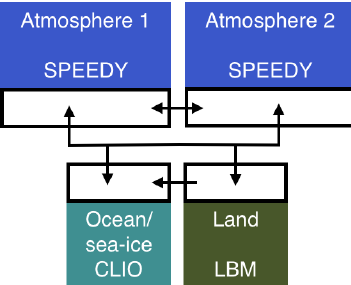
Figure 2. Schematic representation of the SPEEDO supermodel training (Selten et al., 2017). Table 1. Parameter values of perfect and imperfect